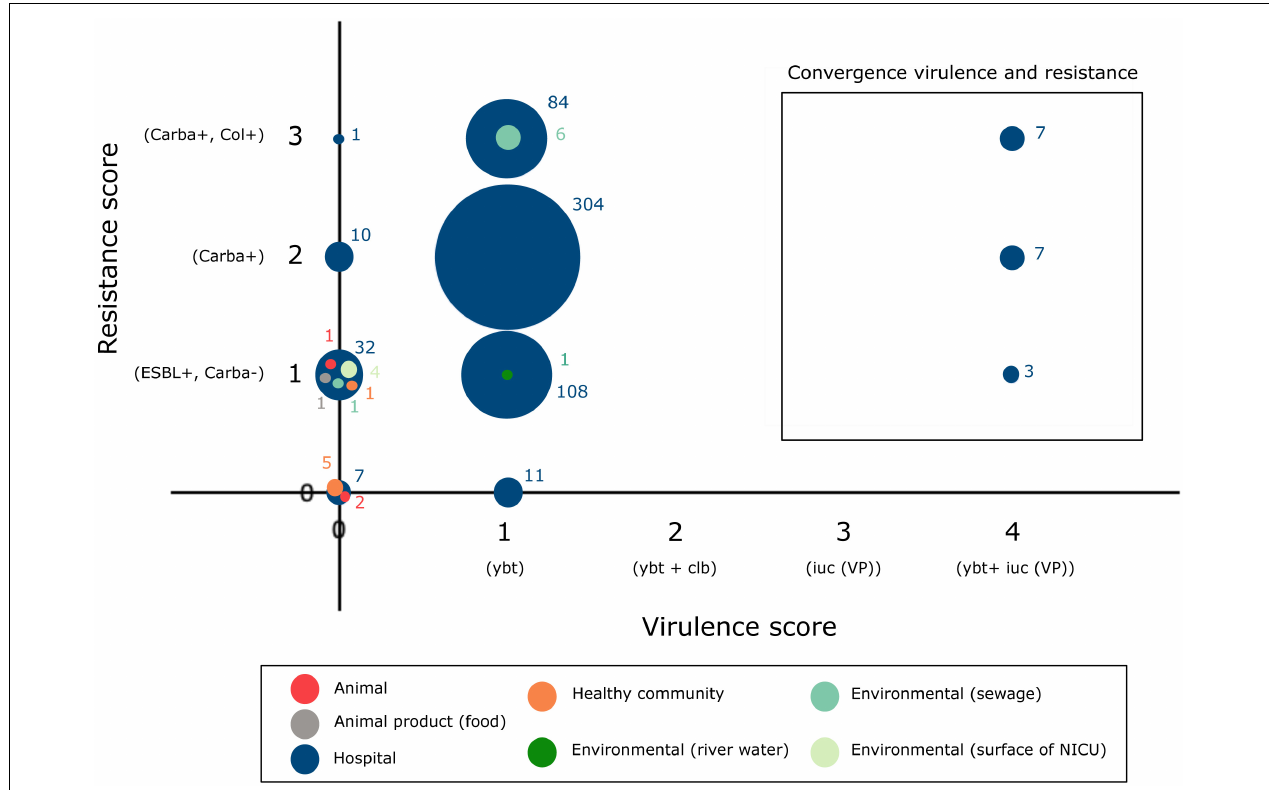
FIGURE 5 | Convergence of antibiotic resistance and virulence in the K. pneumoniae ST101